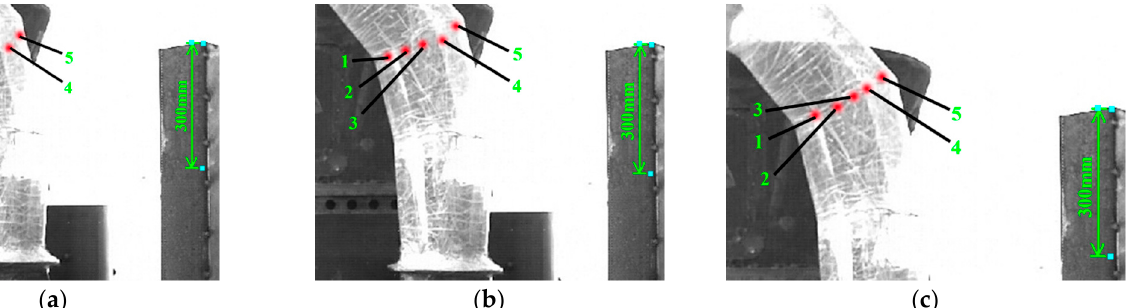
Figure 18. Movement process of crushed straw material near section C. ( a ) t = 1.620 s. ( b ) t = 1.622 s. ( c ) t = 1.624 s.